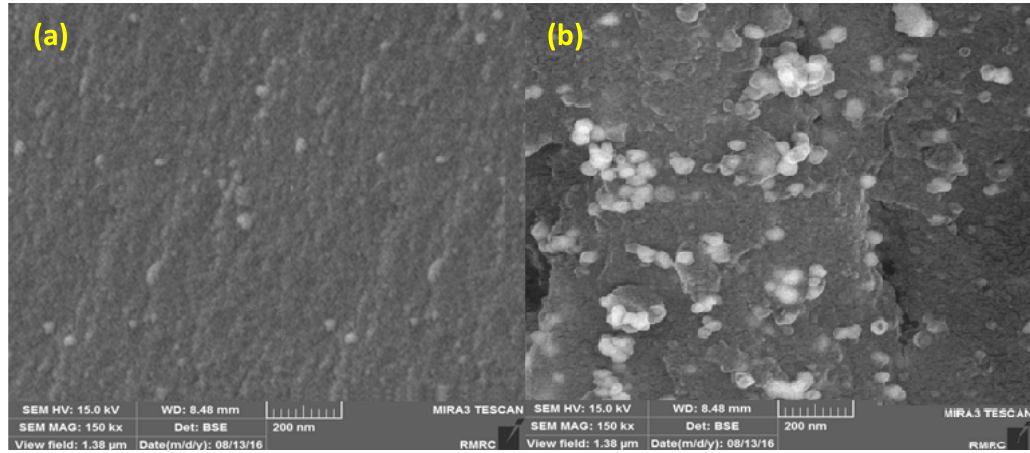
Fig.10 FE-SEM image of (a) TiO 2 /SiO 2 and (b) Ag NPs/TiO 2 /SiO 2 samples Fig. 10. FE-SEM image of (a) TiO 2 /SiO 2 and (b) Ag NPs/TiO 2 /SiO 2